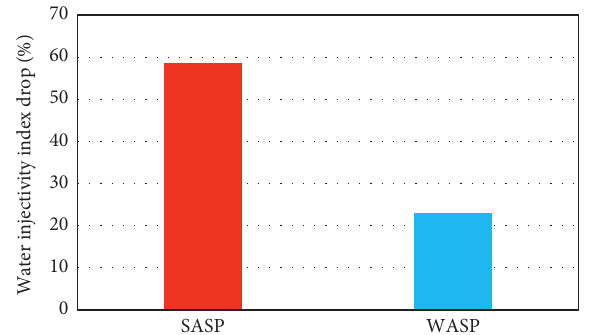
Figure 14: Water injectivity index drop.